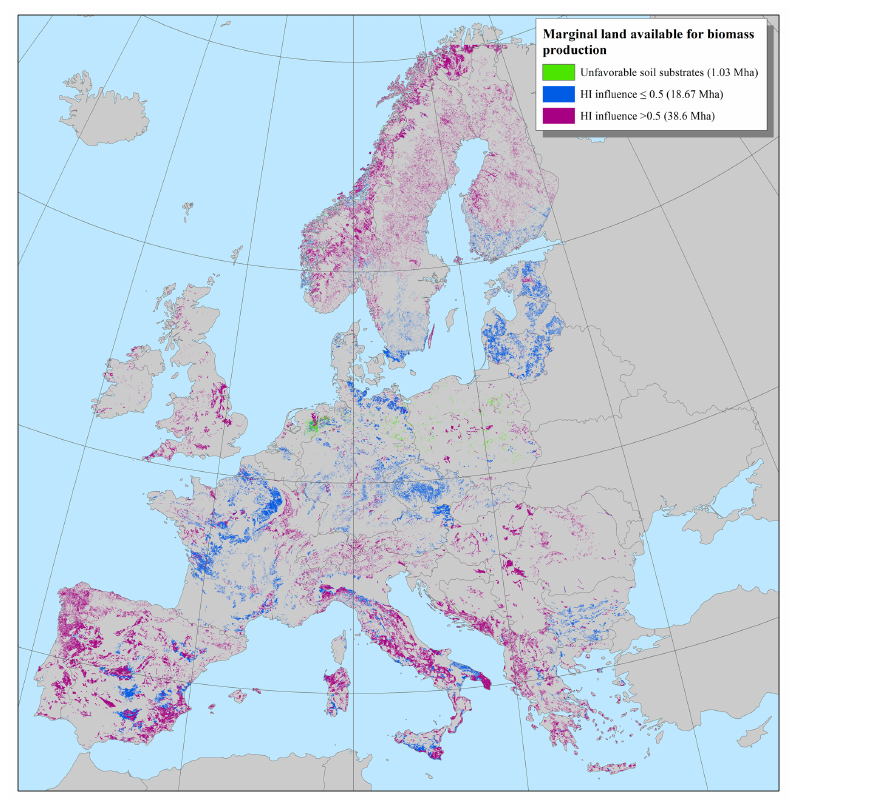
Figure 10. SQR hazard indicators area of influence as marginality factors in Europe. Table 7. Extent of different soil-related hazard indicators for European marginal lands. Hazard indicators with the highest spatial influence on marginality (area > 1 . 0Mha) are given in bold